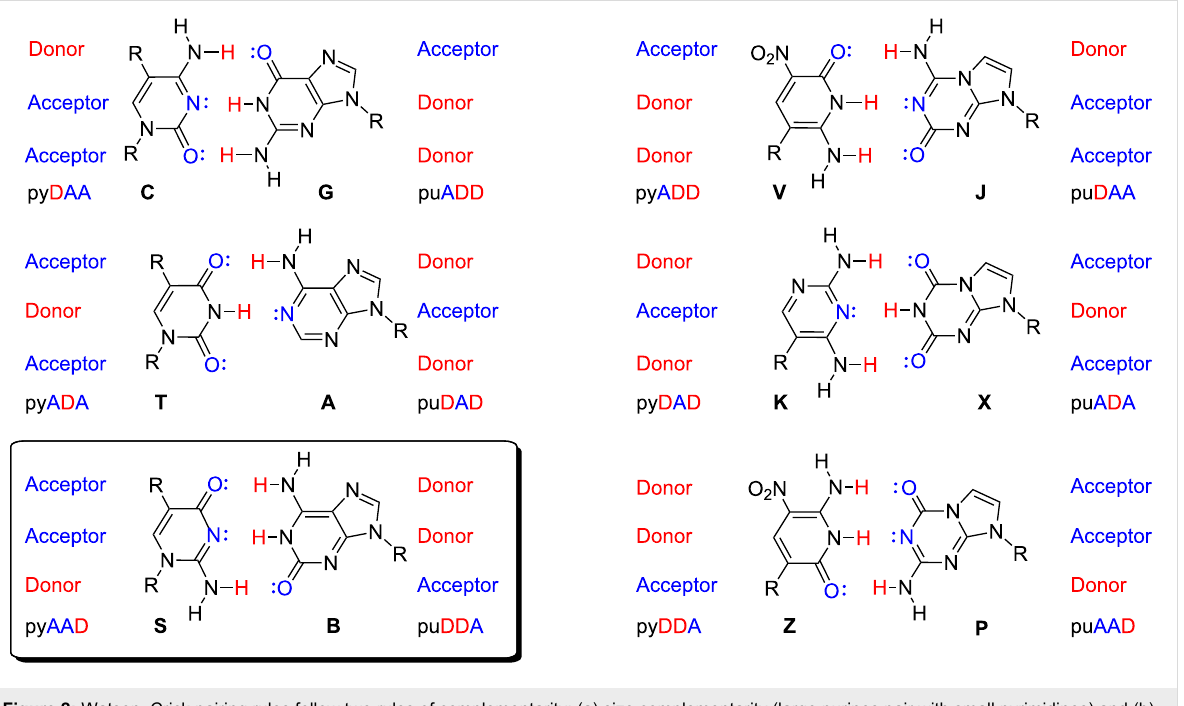
Figure 2: Watson–Crick pairing rules follow two rules of complementarity: (a) size complementarity (large purines pair with small pyrimidines) and (b) hydrogen-bonding complementarity (hydrogen-bond acceptors, A, pair with hydrogen-bond donors, D). Rearranging donor and acceptor groups on the nucleobases, while not changing the geometry of the Watson–Crick pair, creates an artificially expanded genetic information system (AEGIS). AEGIS components add information density to DNA strands built from them. The S : B pair used in this work is highlighted in the